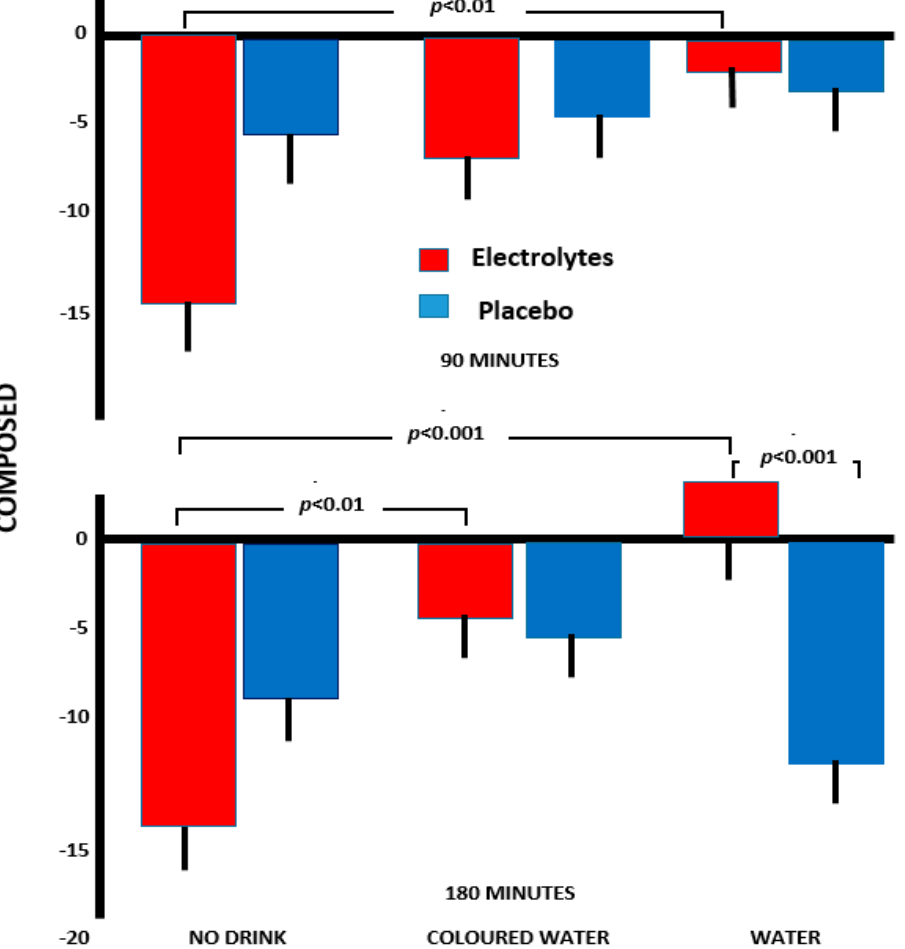
Figure 2. The influence of various drinks on changes over the morning in composure. The data are means +/ − standard errors. A minus score reflects increased anxiety.